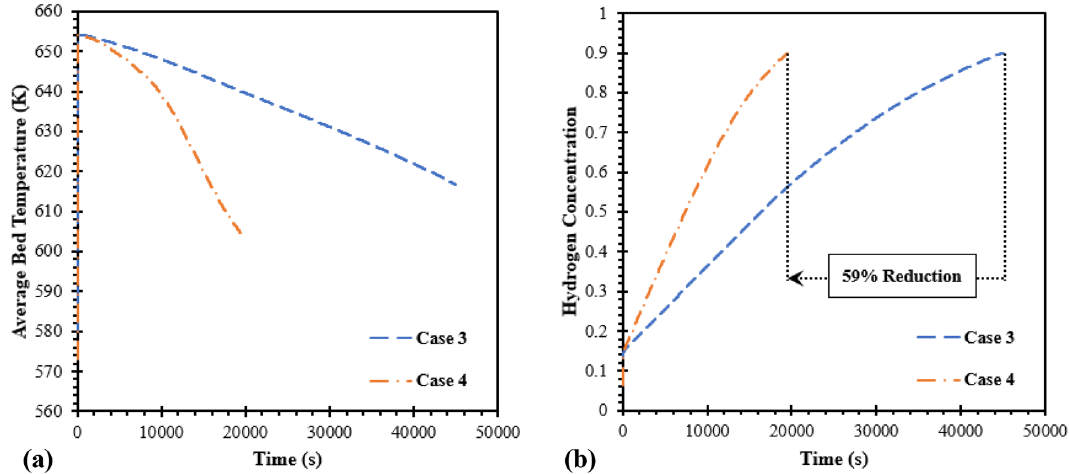
Figure 6. Comparison of average bed temperature and hydrogen concentrations between two heat exchanger configurations as case 3 and case